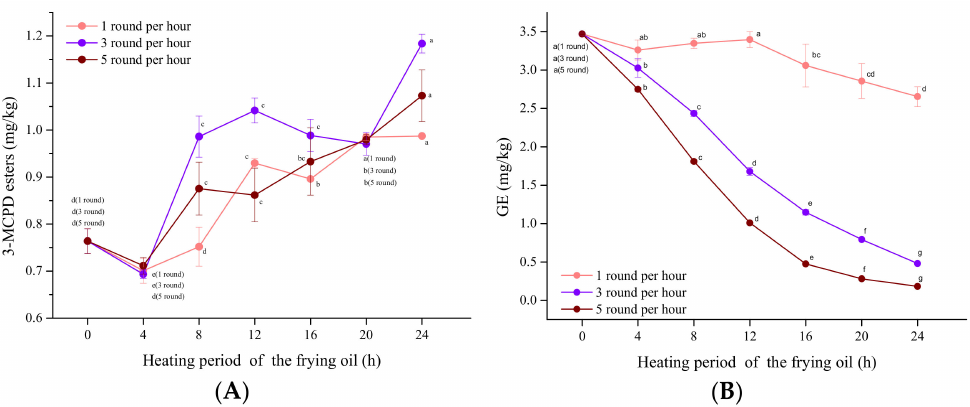
Figure 2. The content of ( A ) MCPDE and ( B ) GE fried oils of different heating periods after frying chicken breast 1, 3, or 5 times per hour. Within each line, points with different letters are significantly ( p < 0.05) different from each